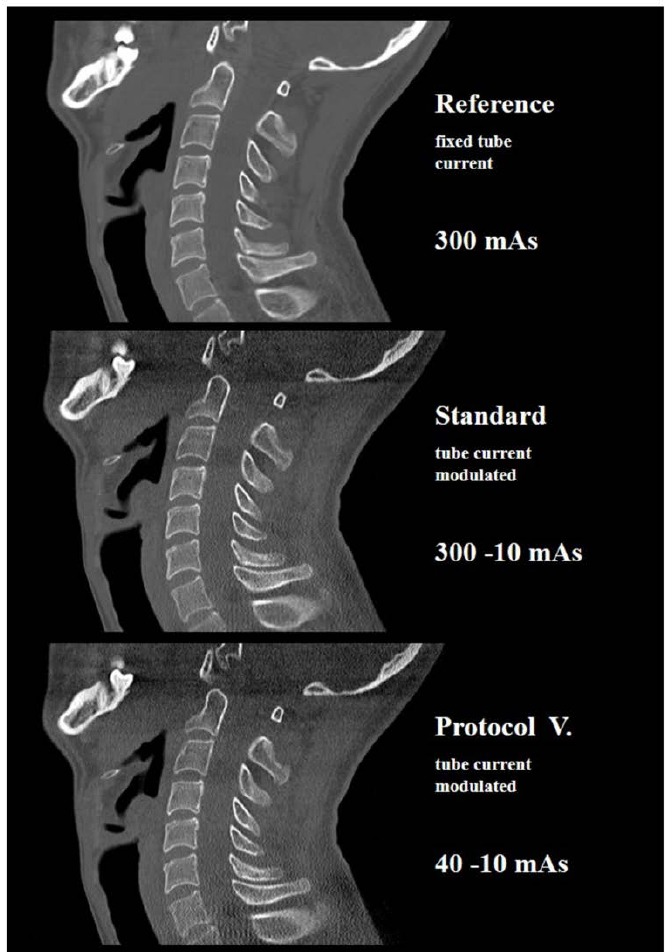
Figure 3. Diagnostic image quality was available with protocol V in this cadaver with a lowered shoulder and presenting with a BMI of 21.9 kg/m 2 and an anteroposterior chest diameter of 17 cm, corresponding to a CTDI of 2.56 mGy and an effective dose of 0.30 mSv. Associated topograms of the same cadaver are shown in Figure